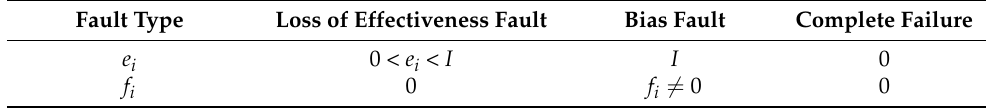
Table 1. The reaction wheel fault types of spacecraft. Fault Type Loss of Effectiveness Fault Bias Fault Complete